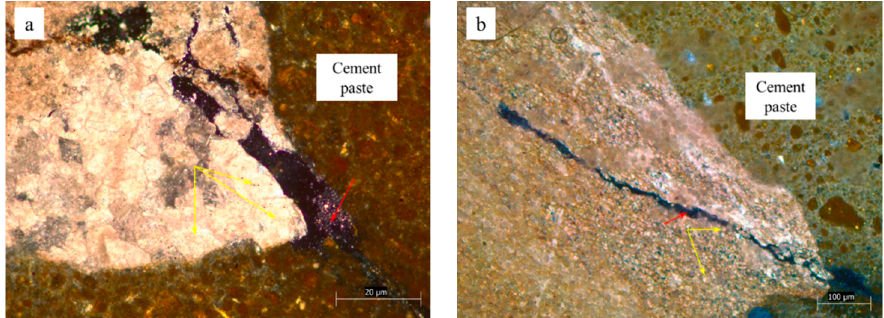
Figure 7. Expansion cracks in concrete microbar cured in TMAH solution for 154 days: ( a ) CG1, ( b ) JT1. Materials 2019 , 12 , x FOR PEER REVIEW